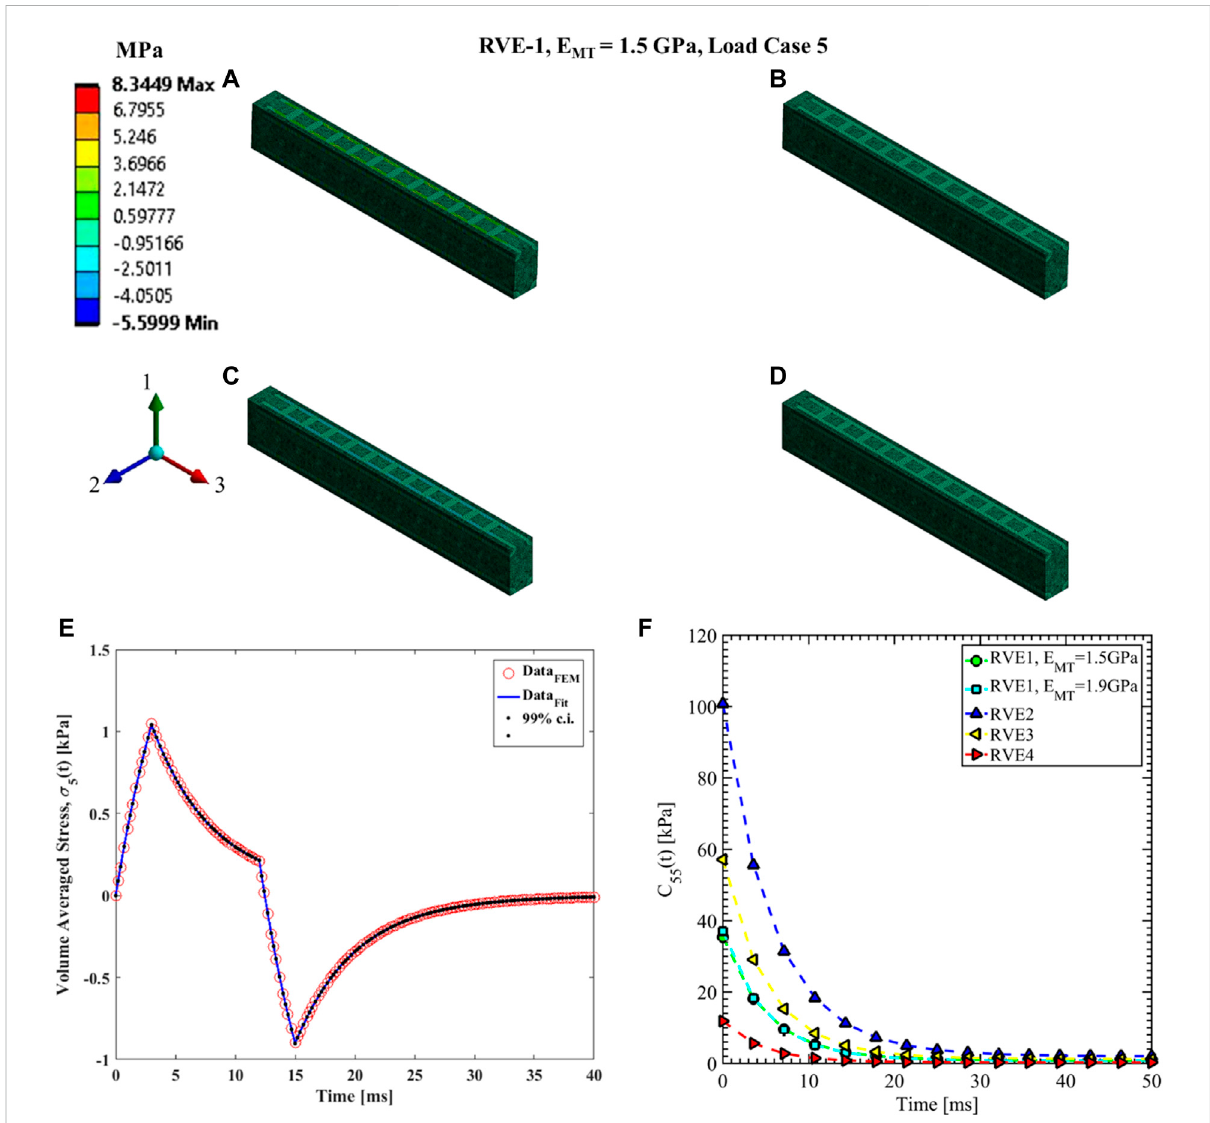
FIGURE 13 Contour plot of the element shear stress in directions 1 and 3 ( [ σ 5 ( t )] ρ from Eq. 16). C 55 ( t ) estimation for the RVE-1 with E MT (cid:2) 1 . 5 GPa by imposing the load case 5. (A) t 1 (cid:2) 3 ms , δ 5 ( t 1 ) (cid:2) 3 nm (B) t 2 (cid:2) 12 ms , δ 5 ( t 2 ) (cid:2) 3 nm (C) t 3 (cid:2) 15 ms , δ 5 ( t 3 ) (cid:2) 0 nm (D) t 4 (cid:2) 40 ms , δ 5 ( t 4 ) (cid:2) 0 nm . (E) Nonlinear regression data fi t with 99% con fi dence interval (c.i.) is shown for volume averaged shear stress in directions 1 and 3 for RVE-1, E MT (cid:2) 1 . 5 GPa for load case 5. (F) Comparison of C 55 ( t ) for different